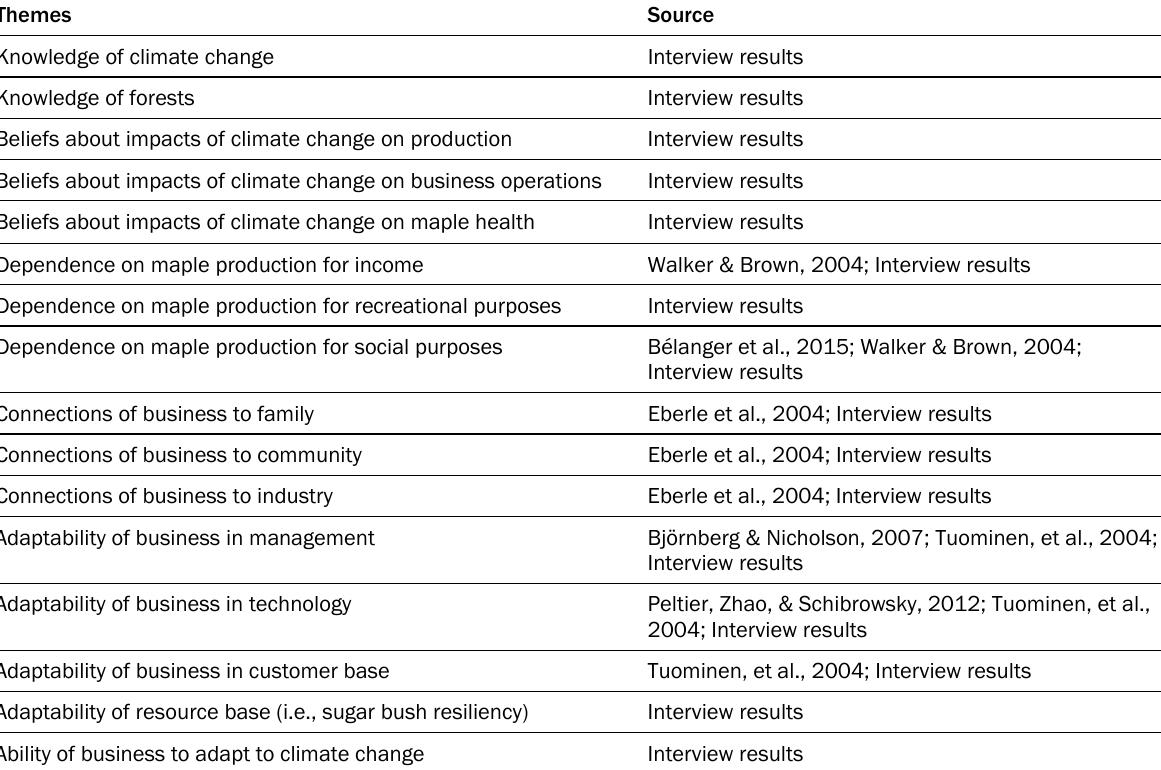
Table 1. Themes Used to Write the Mail and Online